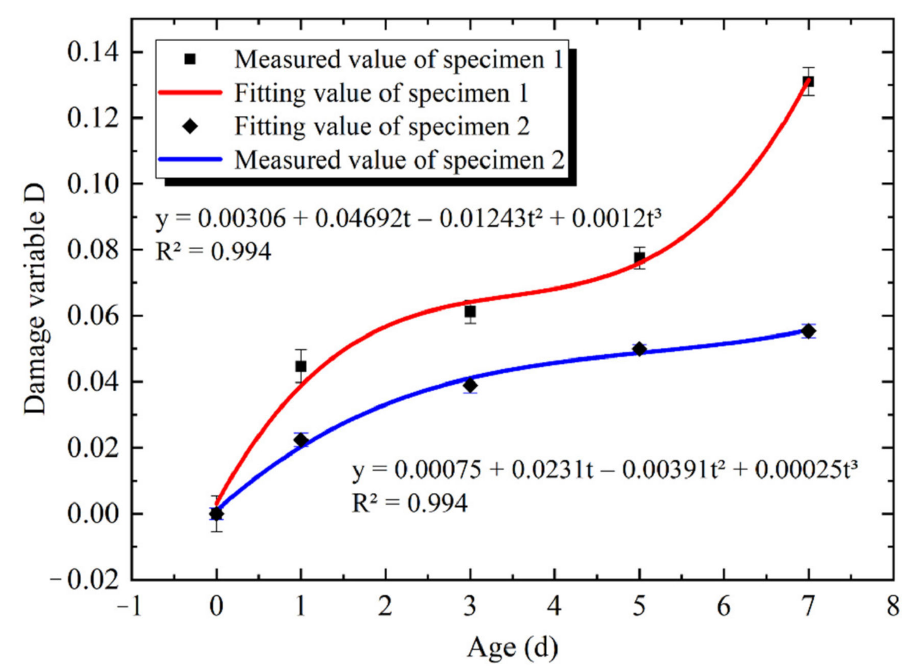
Figure 7. Comparative relationship between damage variable D and loading age t